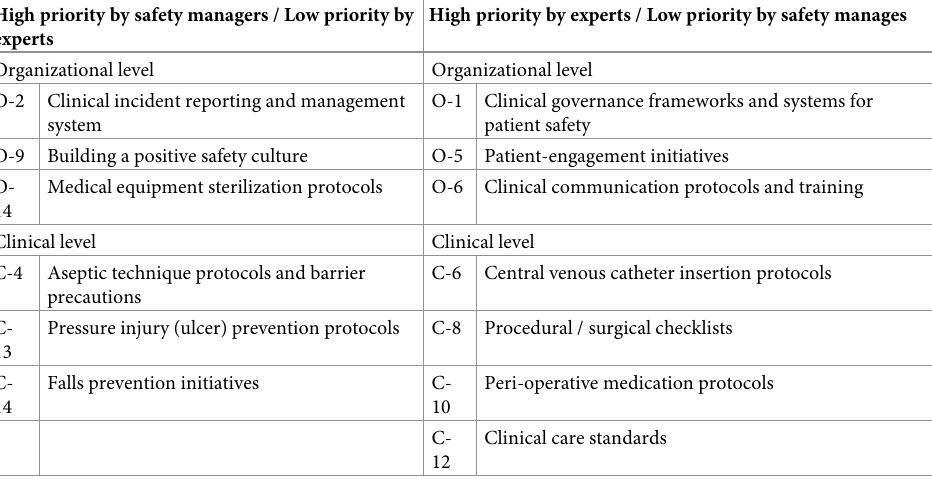
Table 6. A summary list of interventions according to the priorities given by experts and safety managers. High priority by safety managers / Low priority by